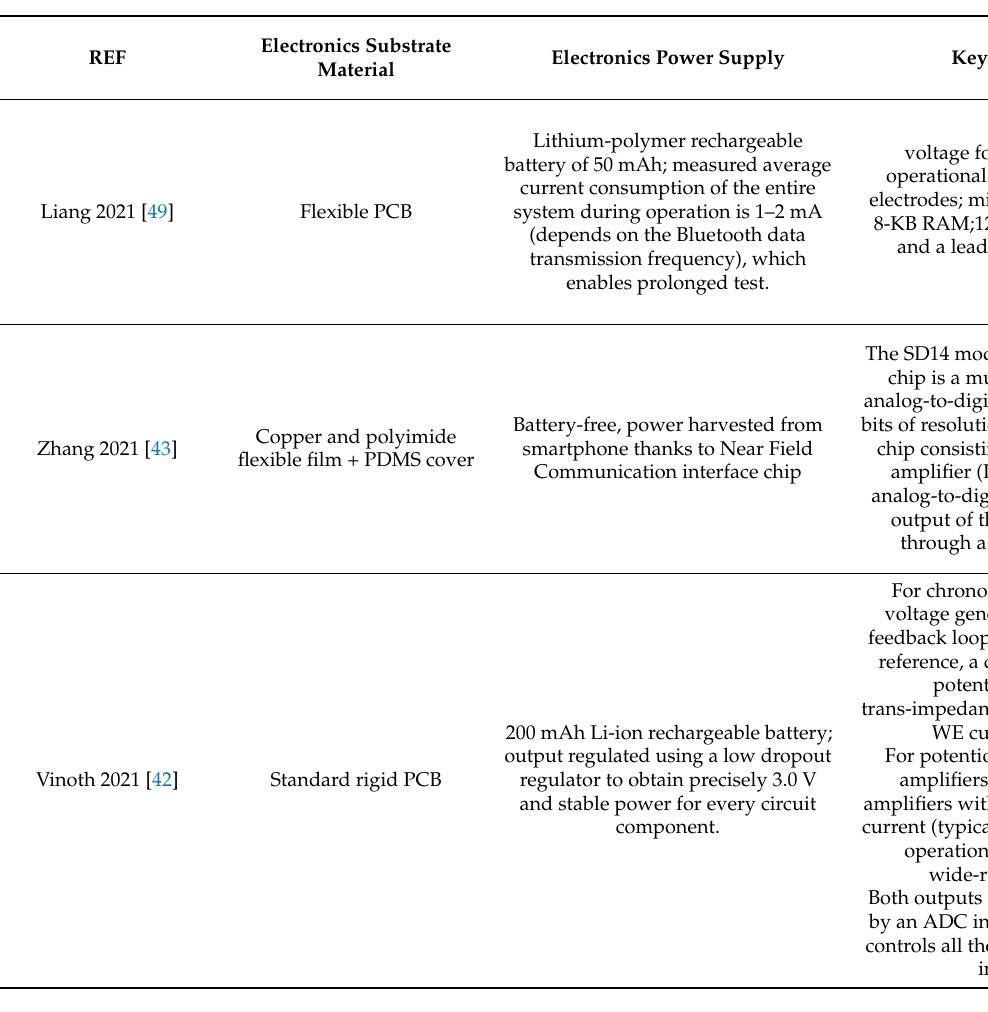
Table 5. Summary of electronics specific